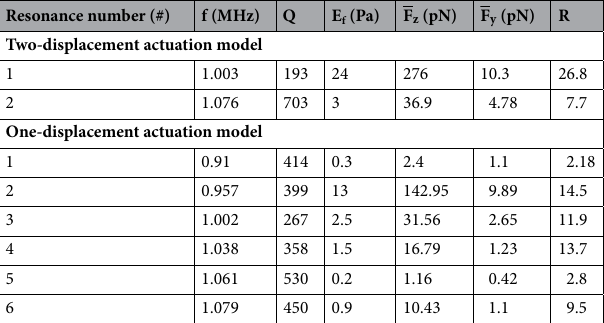
Table 1. The value of resonance frequency f, Q factor, acoustic energy density of the fluid ( E f ) , average acoustic radiation force in the z direction ( F z ), and average acoustic radiation force in the y direction ( F y ) shown in Fig. 1 for the aluminum microchannel modeled in this